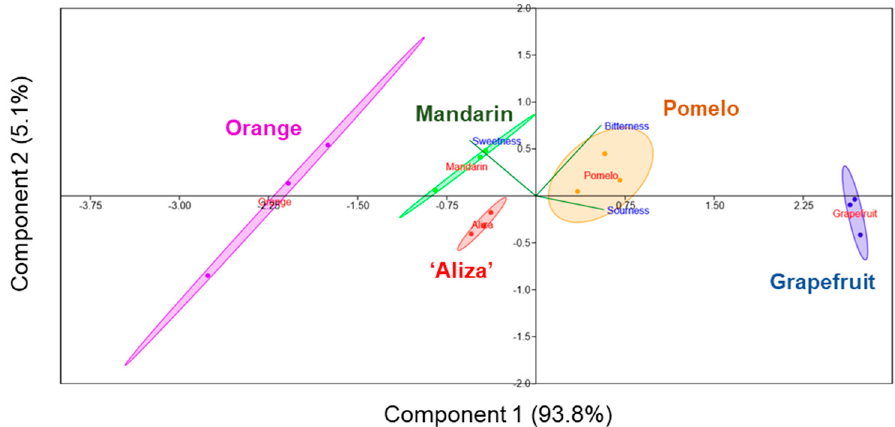
Figure 7. Biplot PCA chart of electronic-tongue data for ‘Aliza’, grapefruit, pomelo, orange and mandarin. The marked ellipses indicate the 95% probability that a new observation from the same group will fall inside the ellipse.